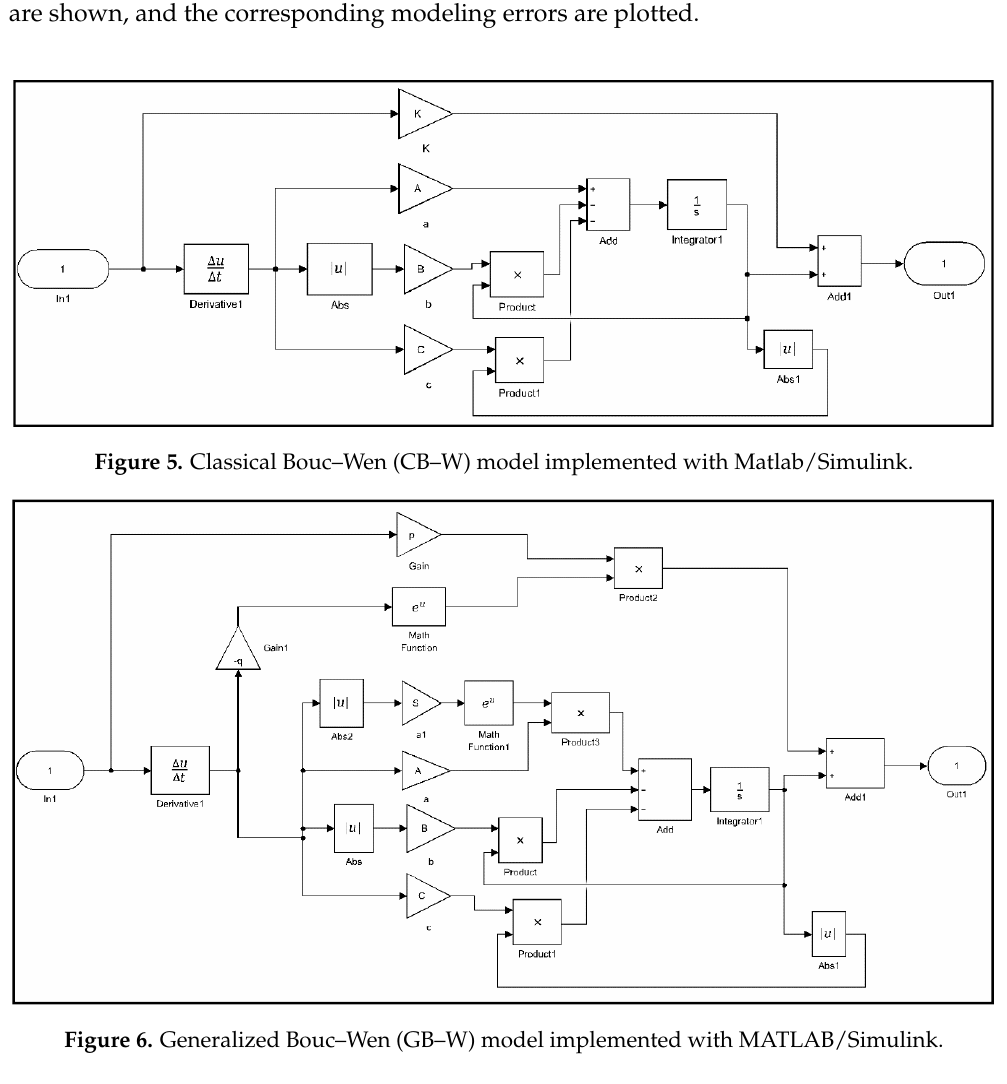
Figure 7. Experimental setup. The position of the moving stage was simultaneously measured by the strain gauge position sensor (SGS), which is included in the piezoelectric ceramic actuator. To achieve the real-time control, the dSPACE-DS1104 rapid prototyping controller board equipped with a 16-bit analogue-to-digital converter (ADC) and 16-bit digital-to-analogue converter (DAC) was used as the real-time control